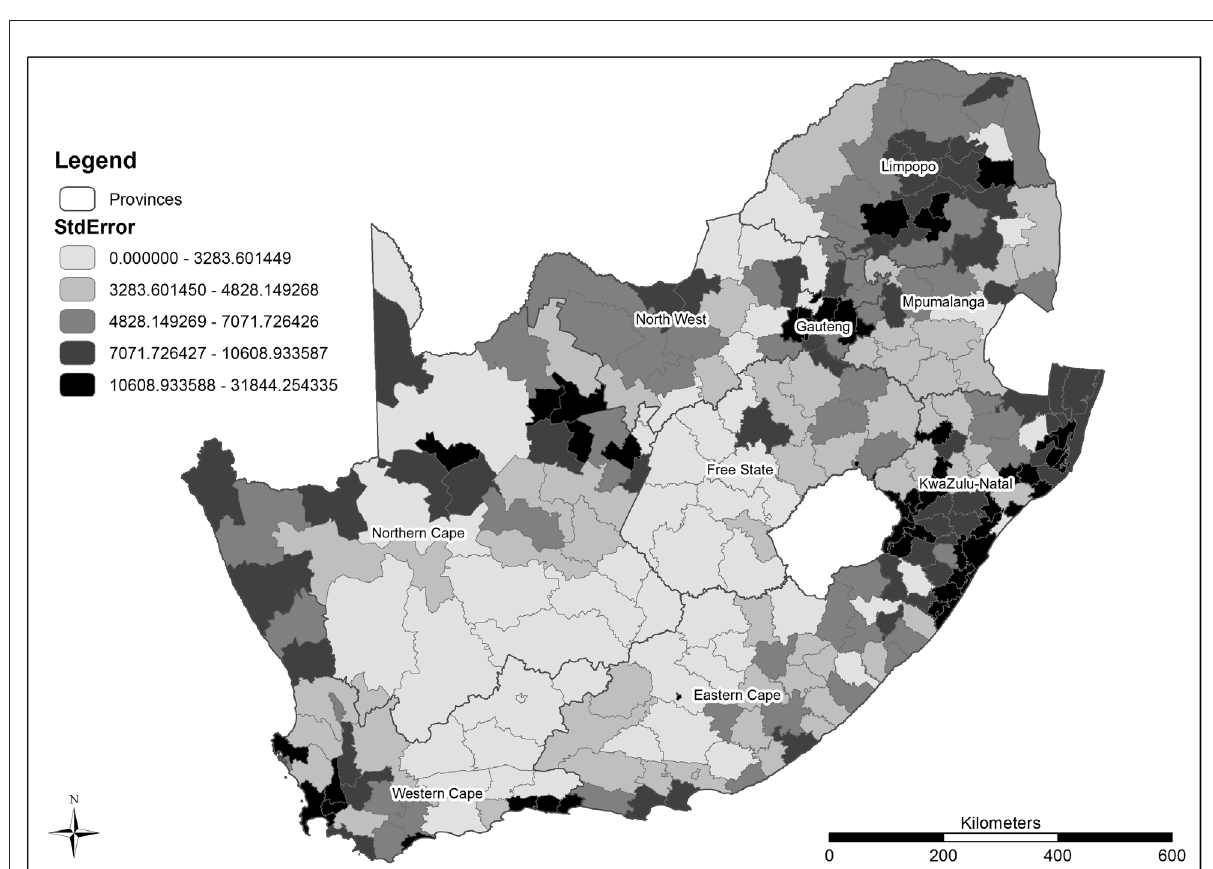
Figure 5: Standard errors in the 1996 predicted unemployment